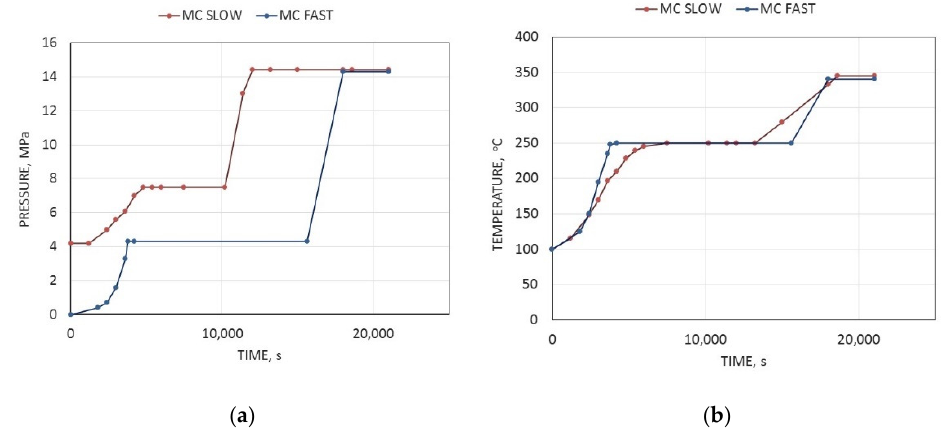
Figure 3. Changes in ( a ) steam pressure and ( b ) temperature within a drum under cold startup operation with lower (MC SLOW) and higher (MC FAST) rates of change of steam temperature.